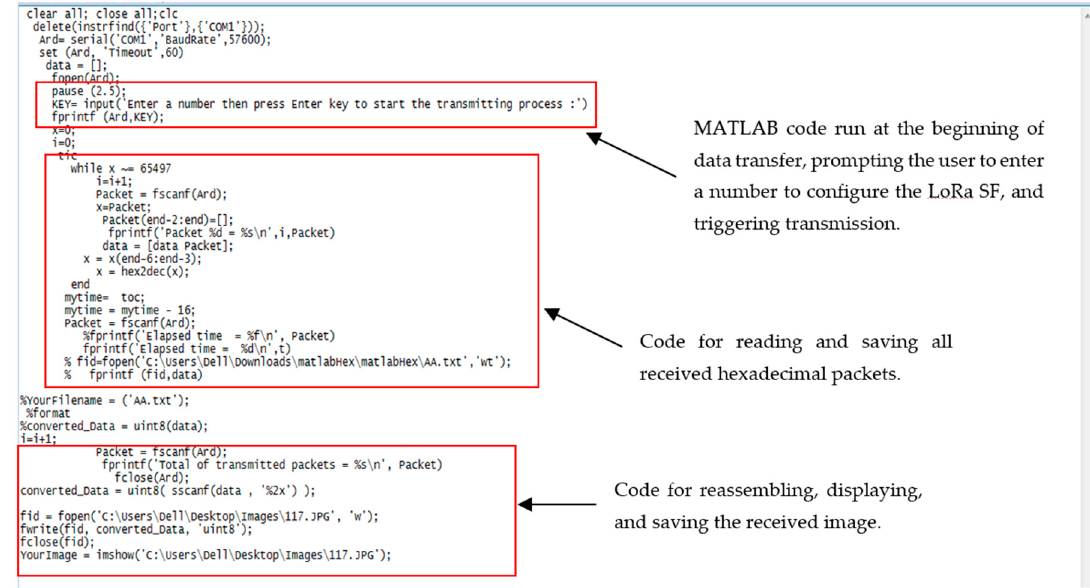
Figure A5. The MATLAB controls for initiating the image capture process and reassembling image files from transmitted hexadecimal packets.